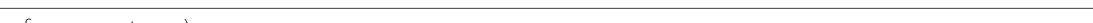
figure on next Fig. 6 Inhibition of P2X7R attenuated IS-induced NLRP3 inflammasome activation and pyroptosis on neurons and microglia in the cerebral cortex and hippocampus. ( a, d ) Double immunofluorescence staining showed a reduction in CC1-positive (marker of inflammasome activation) neurons (NeuN positive) and microglia (Iba-1 positive) in the cerebral cortex and hippocampus of IS-BBG mice compared to IS-VEH mice. ( b, e ) Double immunofluorescence showed similar CC3-positive (apoptotic marker) neurons (NeuN positive) in the cerebral cortex and hippocampus of the four groups of mice. ( c, f ) Double immunofluorescence staining showed a reduction in GSDMD-positive (pyroptotic marker) neurons (NeuN positive) and microglia (Iba-1 positive) in the cerebral cortex and hippocampus of IS-BBG mice compared to IS-VEH mice. Magnification 20 μm. Images were taken under identical exposures and conditions. Abbreviations: IS, inflammatory soup; CC1, cleaved caspase-1; CC3, cleaved caspase-3; GSDMD, Gasdermin D; NeuN, neuronal nuclei; Iba-1, ionized calcium-binding adaptor molecule-1; GFAP, glial fibrillary acidic protein; BBG, brilliant blue G; VEH,